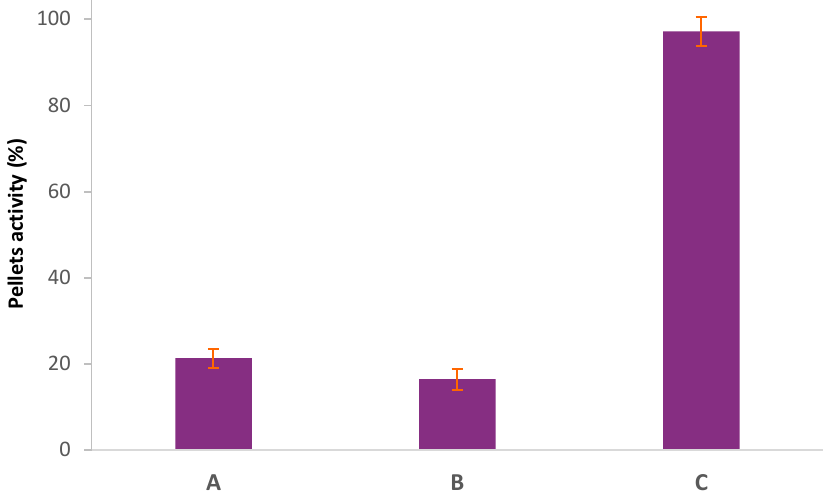
Figure 5. Methanol precipitation assay of ( A ) effector molecule (Tetrazine-substituted Poly-L-Lysine, Tz-PL), ( B ) effector molecule in the presence of the monoclonal antibody trastuzumab (Herceptin ® ) without transcyclooctene (TCO), and ( C ) effector molecule reacted with TCO-conjugated monoclonal antibody (click product).